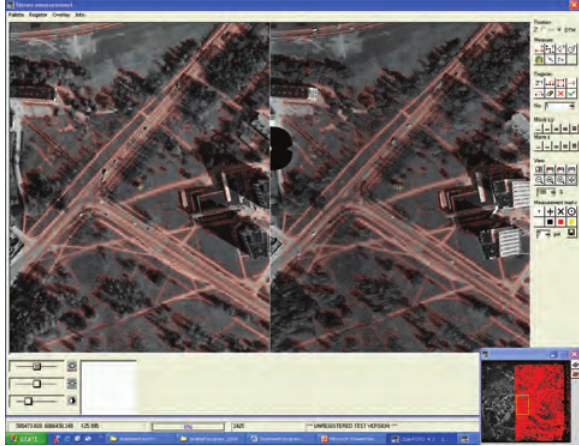
Fig. 5. Fragment of relief model in stereoscopic measurement mode. Number of correlated points – 233 610